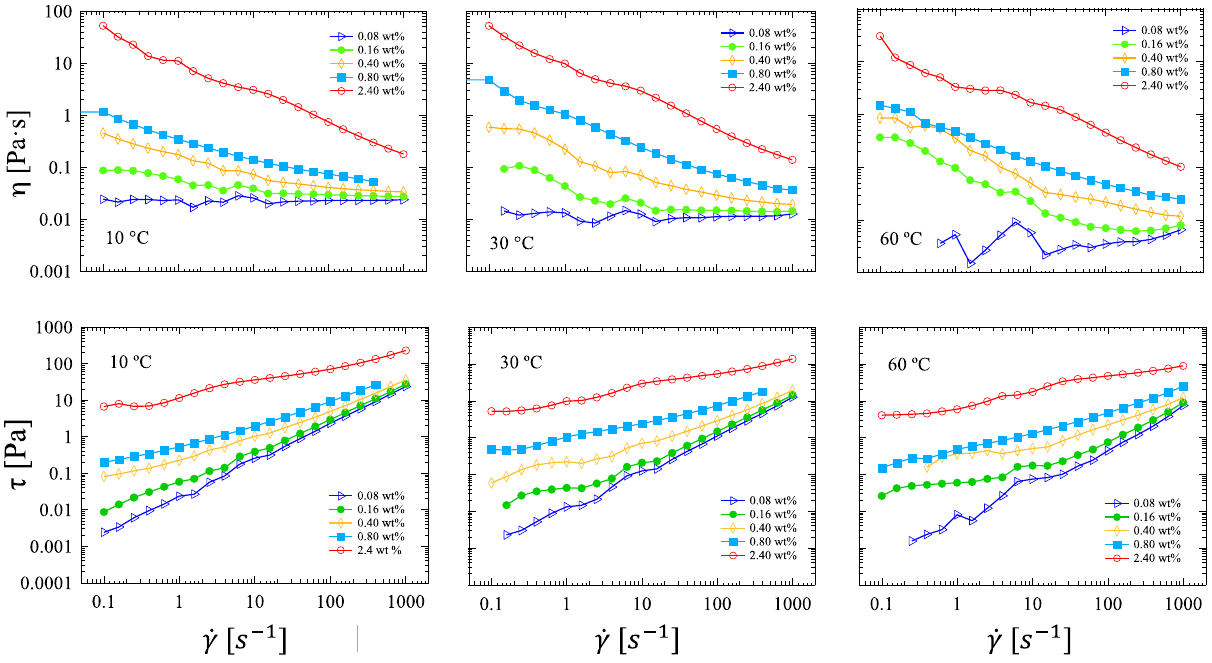
Figure 2. Flow curves in terms of both shear viscosity (upper line) and shear stress (bottom line) of ink suspensions at five different HRCM concentrations obtained via log ramp sampling rate at three temperatures .